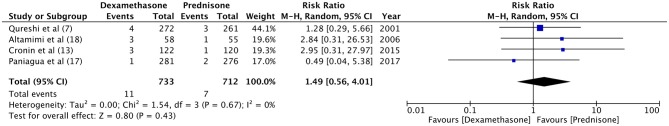
Forrest plot for dexamethasone vs. prednisone for hospital readmission.